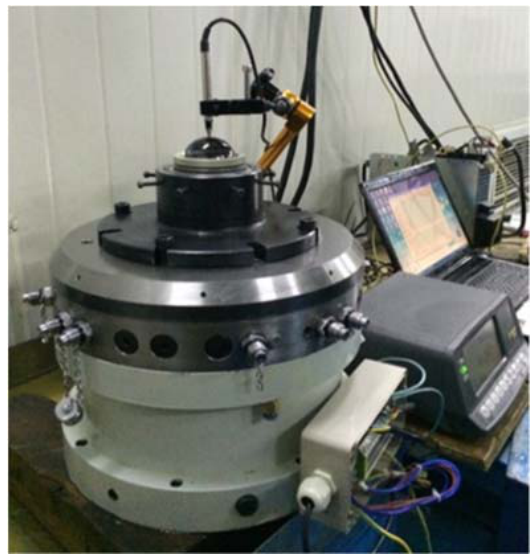
Figure 6. Turntable rotation accuracy detection.